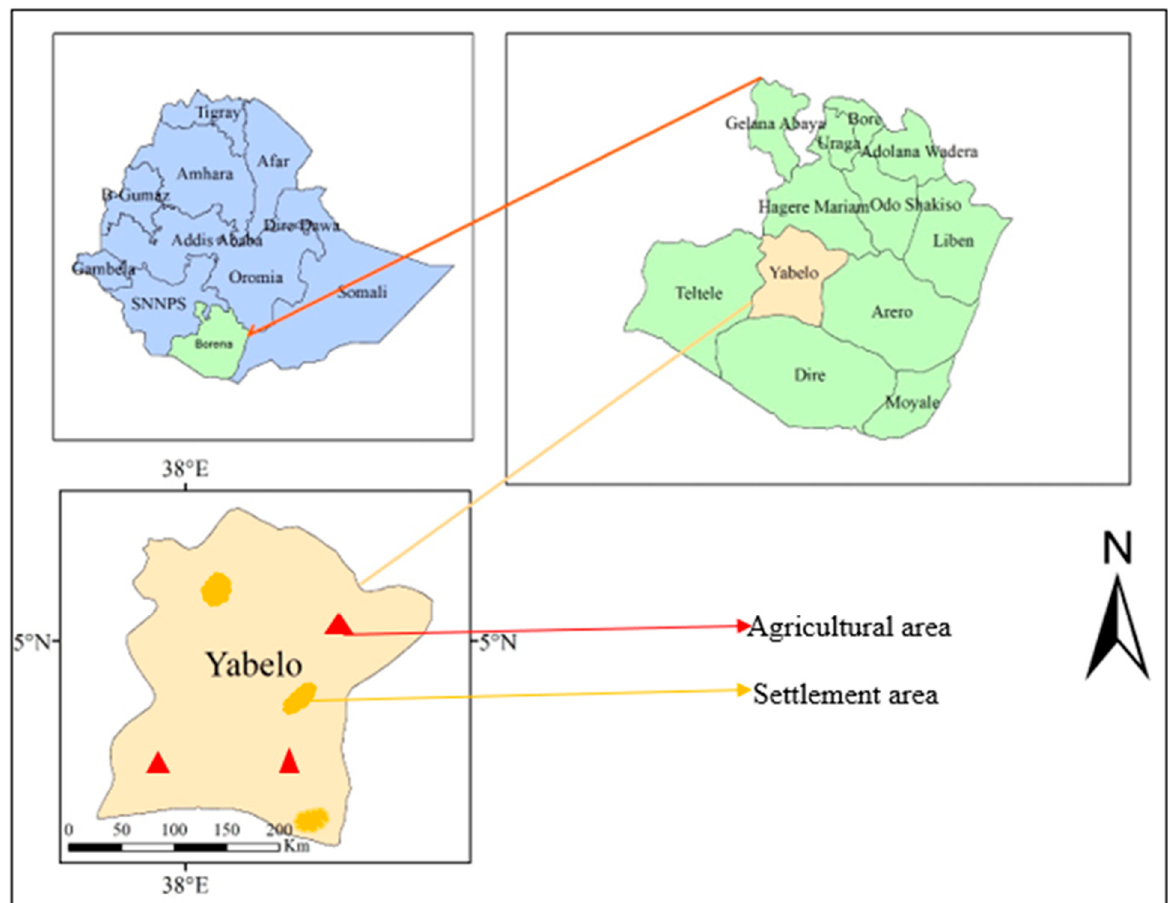
Figure 3. Location of the study area.